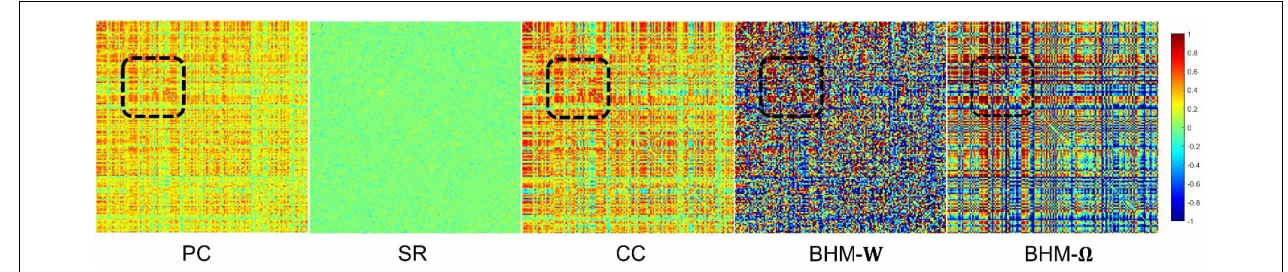
FIGURE 2 | The BFN adjacency matrices of different methods. The patches marked by the black box are the consistent part of the network constructed by different methods.